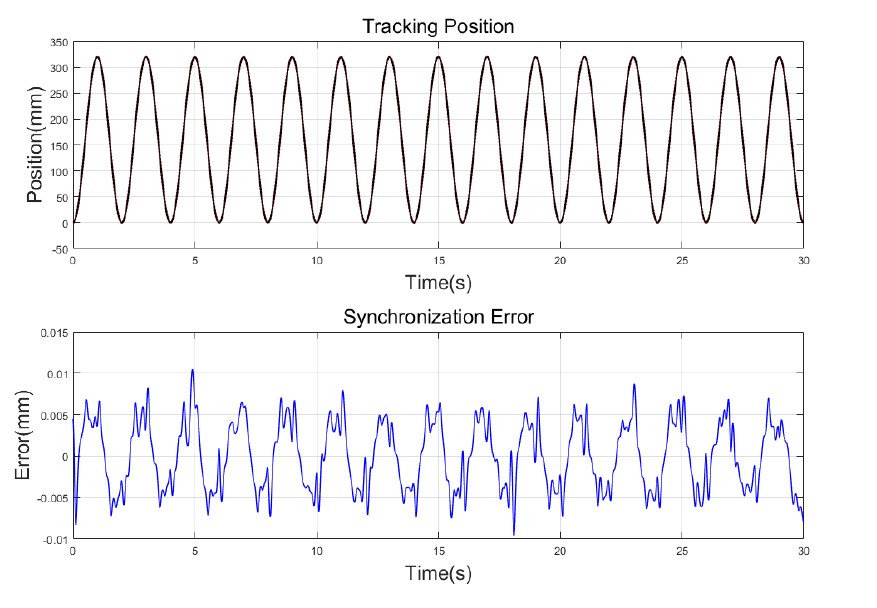
Figure 14. Tracking and synchronization in time domain.